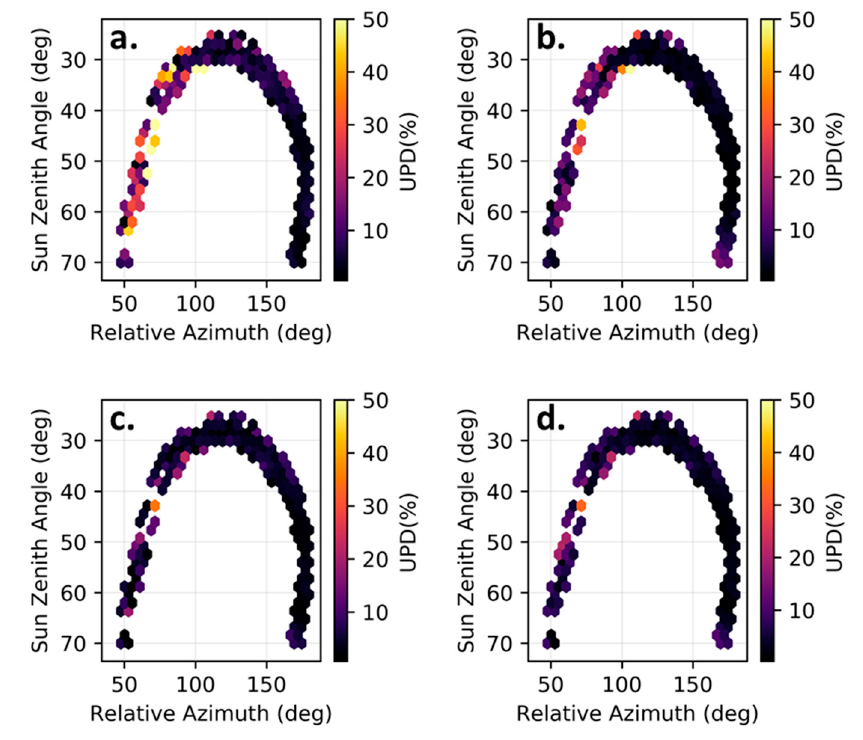
Figure 10. UPD(%) of different R rs models measured in clear-sky conditions at different relative azimuth and sun zenith angles. ( a ) M99(1); ( b ) 3C; ( c ) OSOAA(fine) + J20; ( d ) OSOAA(fine) + R05(2).